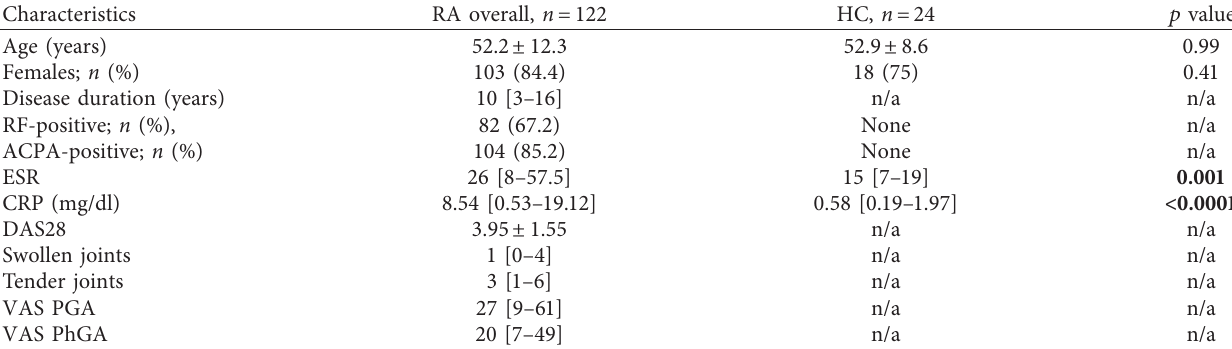
Table 2: Characteristics of patients with rheumatoid arthritis and healthy controls enrolled to the study. Characteristics